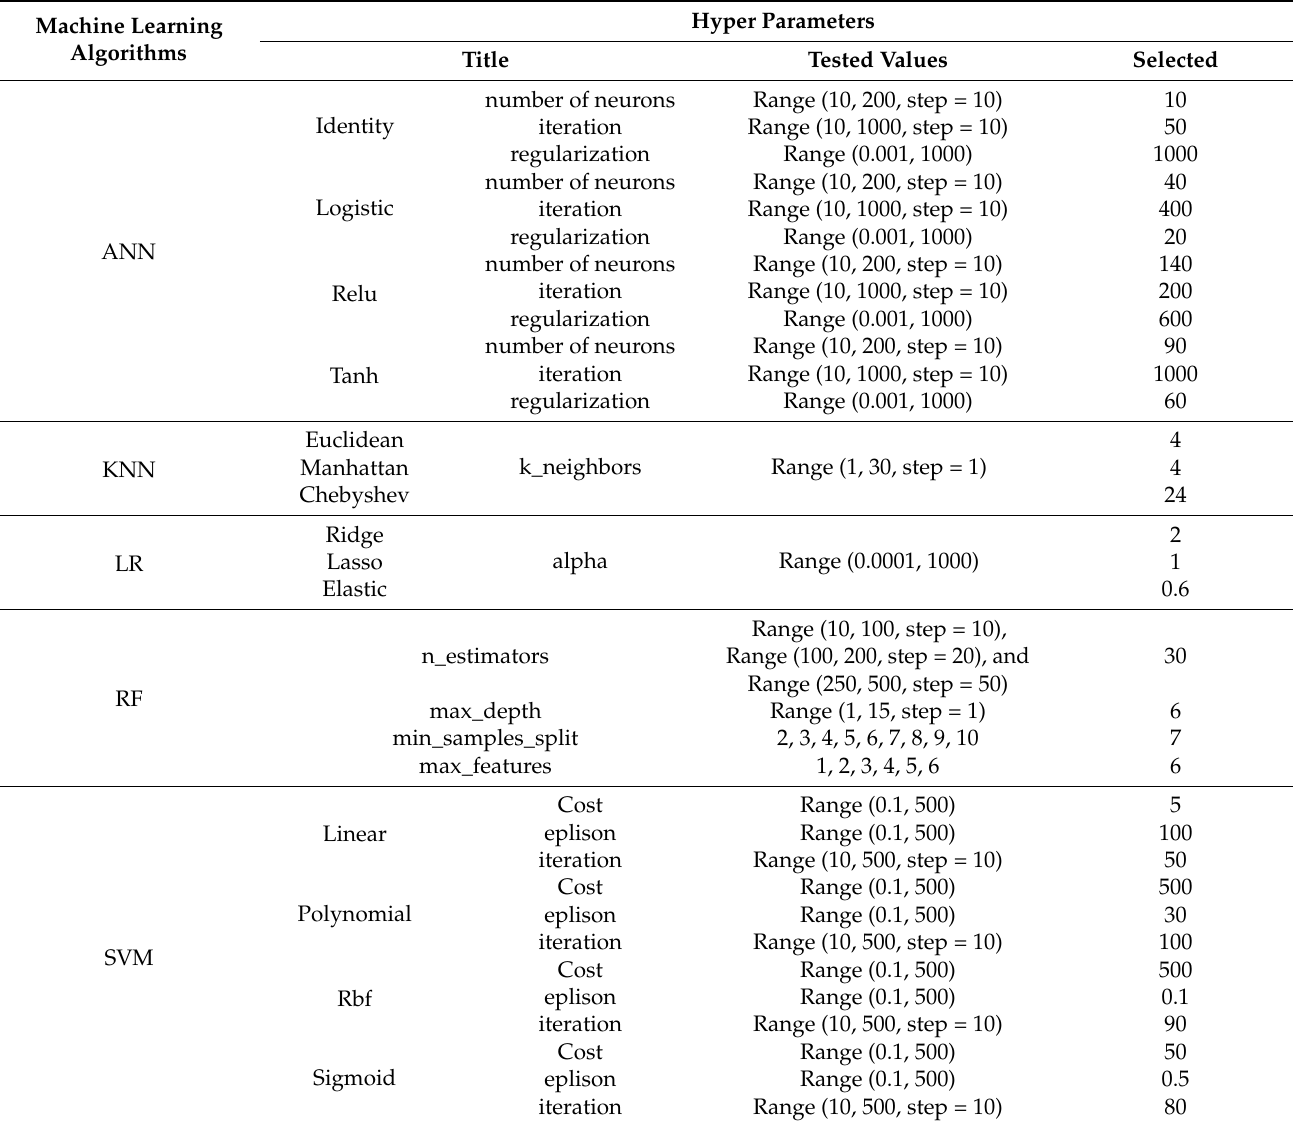
Table 2. Hyperparameters considered for the development of machine learning based predictive